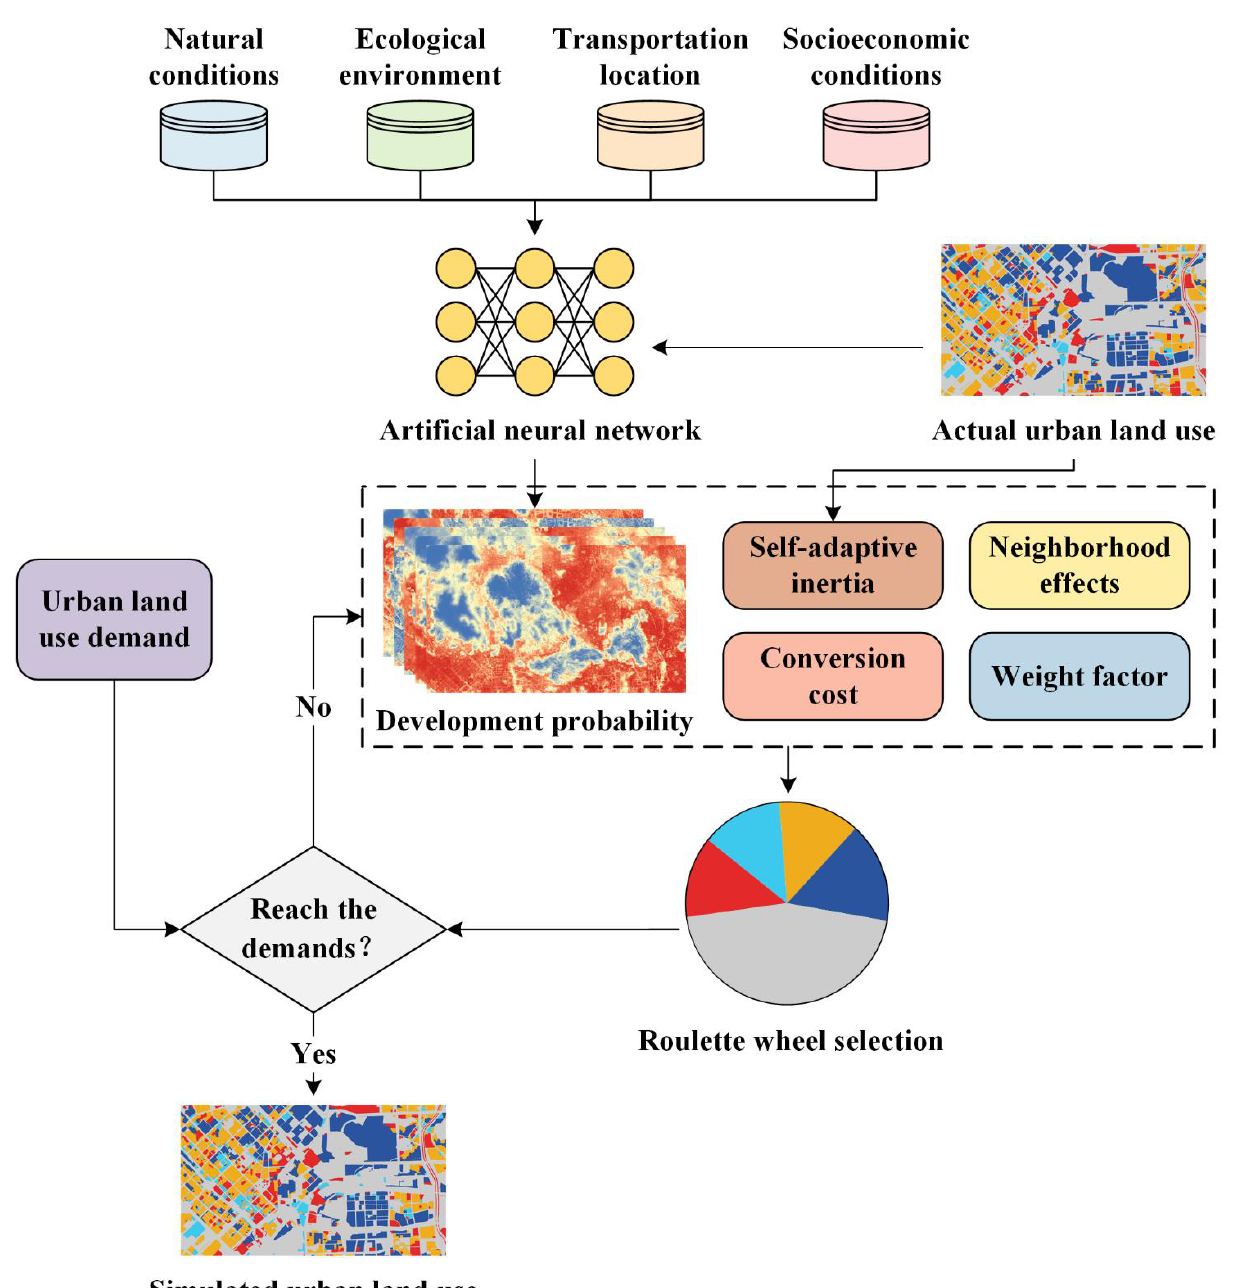
Figure 7. Framework of CA in FLUS model.